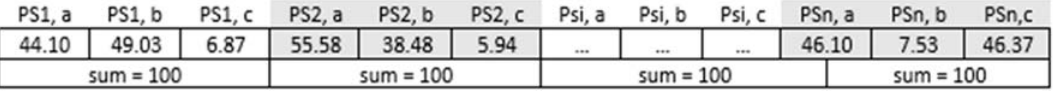
Figure 3. Structure of a particle for the PSM problem.